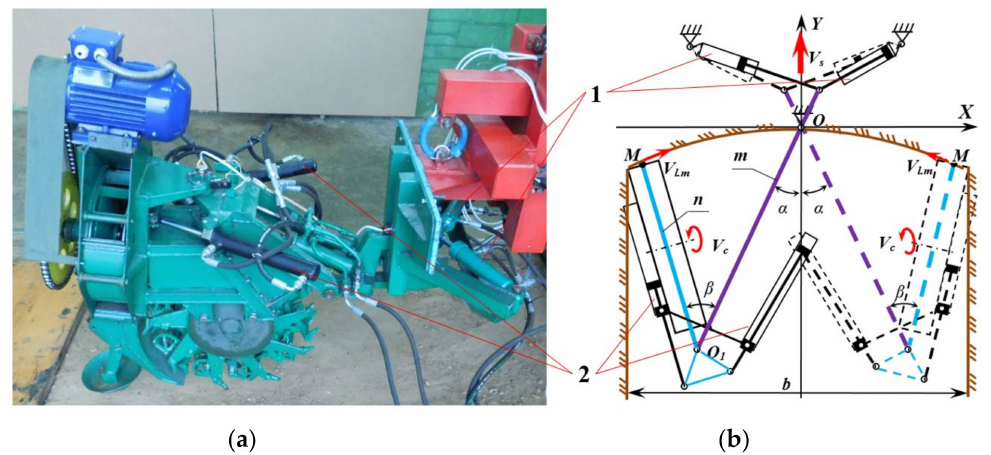
Figure 2. A structural diagram of the double swivel, two-link mounting of the actuator on the base chassis: ( a ) design implementation on the physical model; ( b ) diagram: 1–hydraulic cylinders of lateral movement of the intermediate frame; 2–hydraulic cylinders of lateral movement of a rotor frame ( V s —machinery supply speed; V c —soil cutting speed; V l.m —lateral supply speed; b —trench width; α —rotation angle of the intermediate frame ( ± 15 ◦ ); β —rotation angle of the rotor frame ( ± 45 ◦ ); m —intermediate frame; n —the actuator